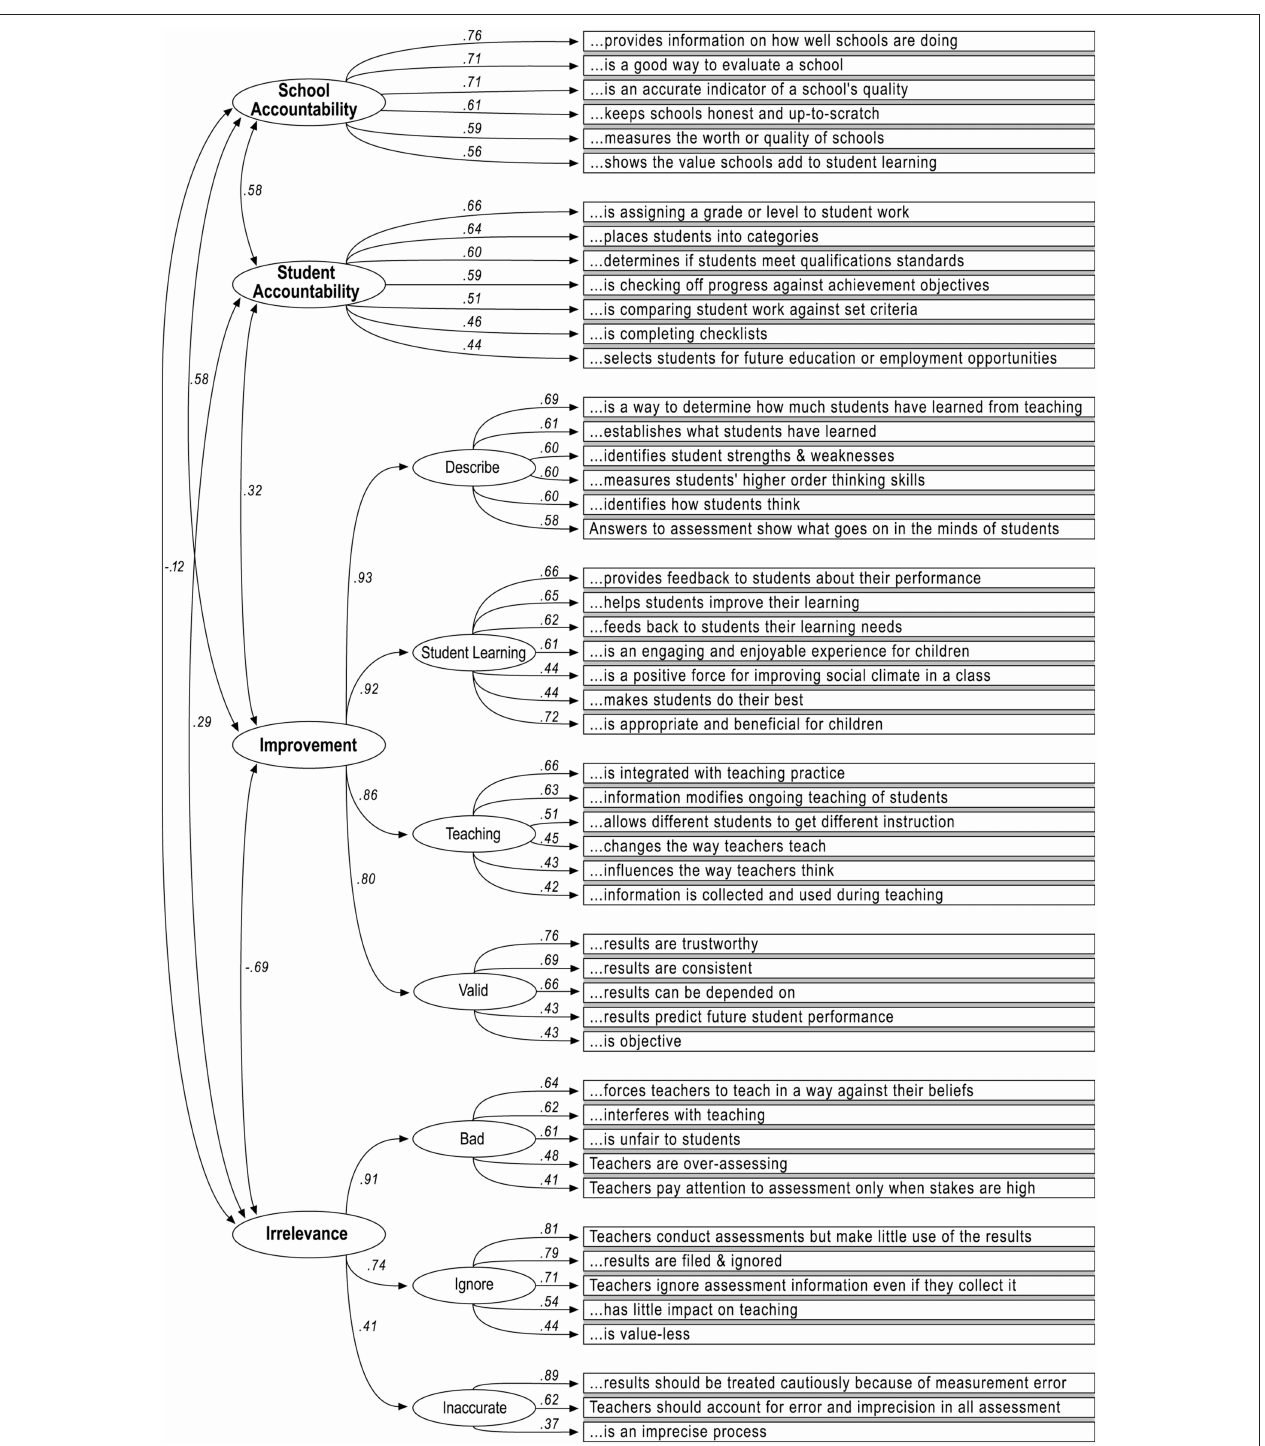
FIGURE 1 | TCoA-III Model with New Zealand Primary School Results. (Figure 1 from Brown (2004b) reprinted by permission of Taylor and Francis Ltd, http://www. tandfonline.com). Zealand secondary teachers (Brown, 2011), Queensland primary and secondary teachers (Brown et al., 2011b), Hong Kong (Brown et al., 2009), Cyprus (Brown and Michaelides, 2011), Egypt